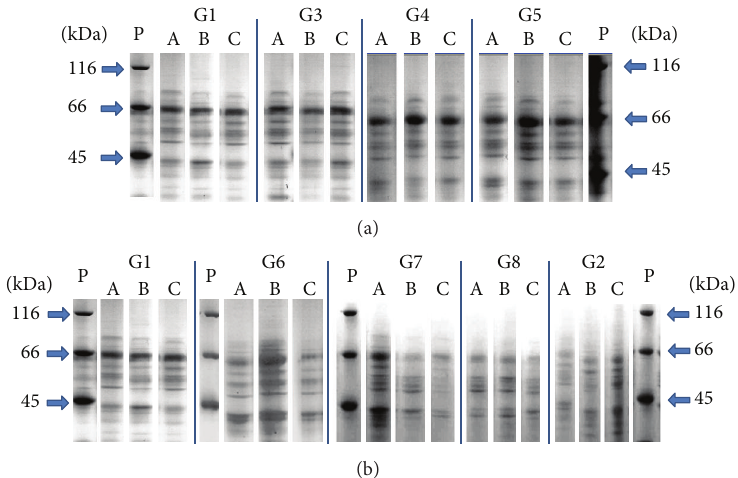
Figure 1: (a) Animal liver SDS-PAGE gels (from 116 to 45 kDa) of positive control group (G1), G3, G4, and G5 and protein standard (P). (b) shows SDS-PAGE gels of G1, G6, G7, and G8, negative control group (G2), and protein standard (P). Letters A, B, and C correspond to three random livers from each